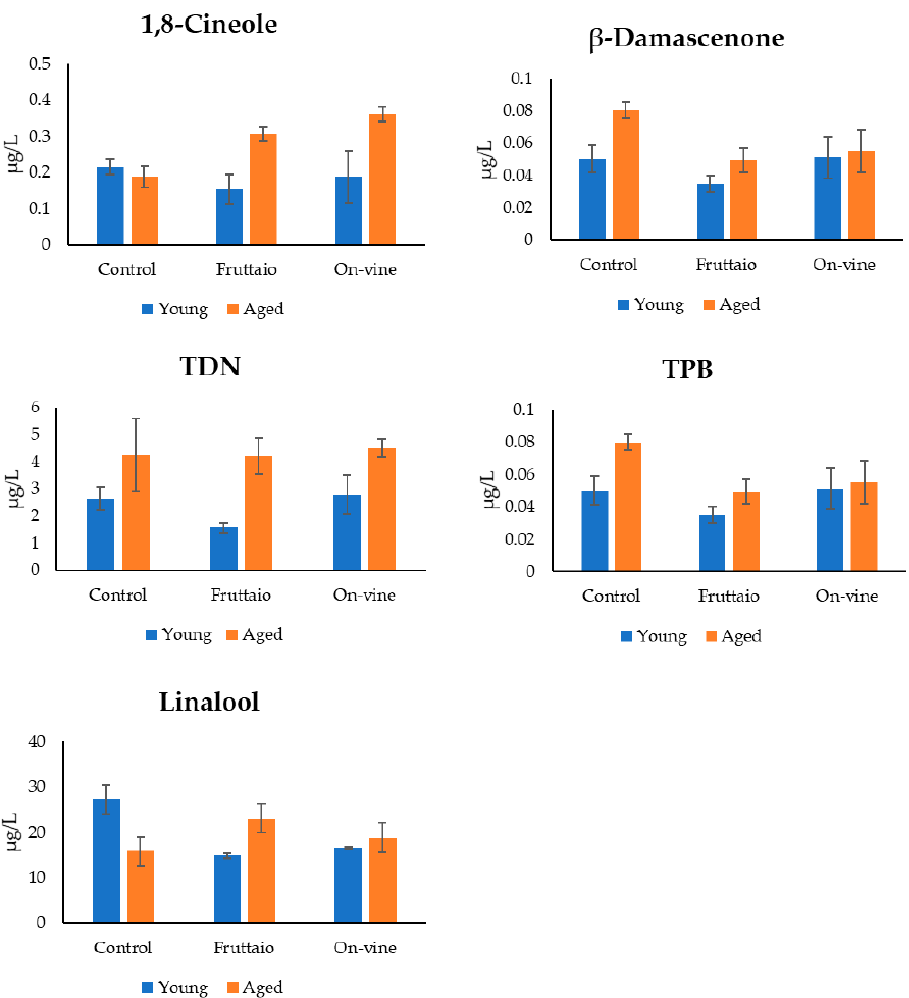
Figure 4. 1,8-Cineole, β -damascenone, ( E )-1-(2,3,6-trimethylphenyl)buta-1,3-diene (TPB),1,1,6-Trimethyl-1,2-dihydronapthalene (TDN) and linalool content in young and model aged wines. The ( E )-1-(2,3,6-trimethylphenyl)buta-1,3-diene (TPB) also showed interesting differences in aged wines. A significant important increase has been observed after aging only in control samples.